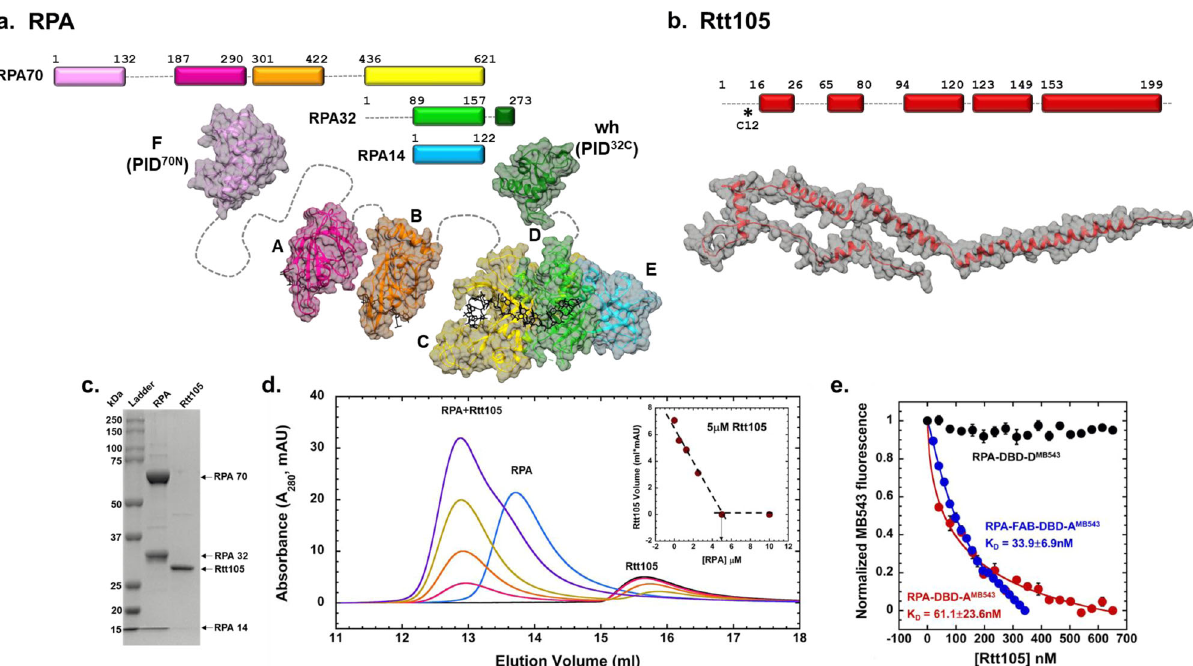
Fig. 1 | Rtt105forms astoichiometric complexwithRPA. a Schematicof theOB- domainsofthethree S.cerevisiae RPAsubunitsisdepictedalongwiththestructures of the individual domains. The domains are spread apartfor clarity and the dotted lines denote the fl exible linkers connecting the domains. ssDNA bound to the individual DBDs (A, B, C and D) is shown as sticks. DBDs-C, D and E are from the cryoEM structure of S. cerevisiae RPA (PDB: 6I52). Homology models for DBD-F (PDB: 5N8A), DBD-A & DBD-B (PDB: 1JMC), and winged helix domains (PDB:4OU0) werebuiltwithSwiss-ModelusingthelistedPDB fi lesastemplate.DNAfrom1JMCis dockedontoDBD-AandBhomologymodels. b AlphaFold(AF-P40063-F1)modelof Rtt105 is shown with predicted α -helices. *Denotes Cys-12 used to generate fl uor- escently labeled Rtt105. c SDS-PAGE analysis of recombinantly puri fi ed RPA and